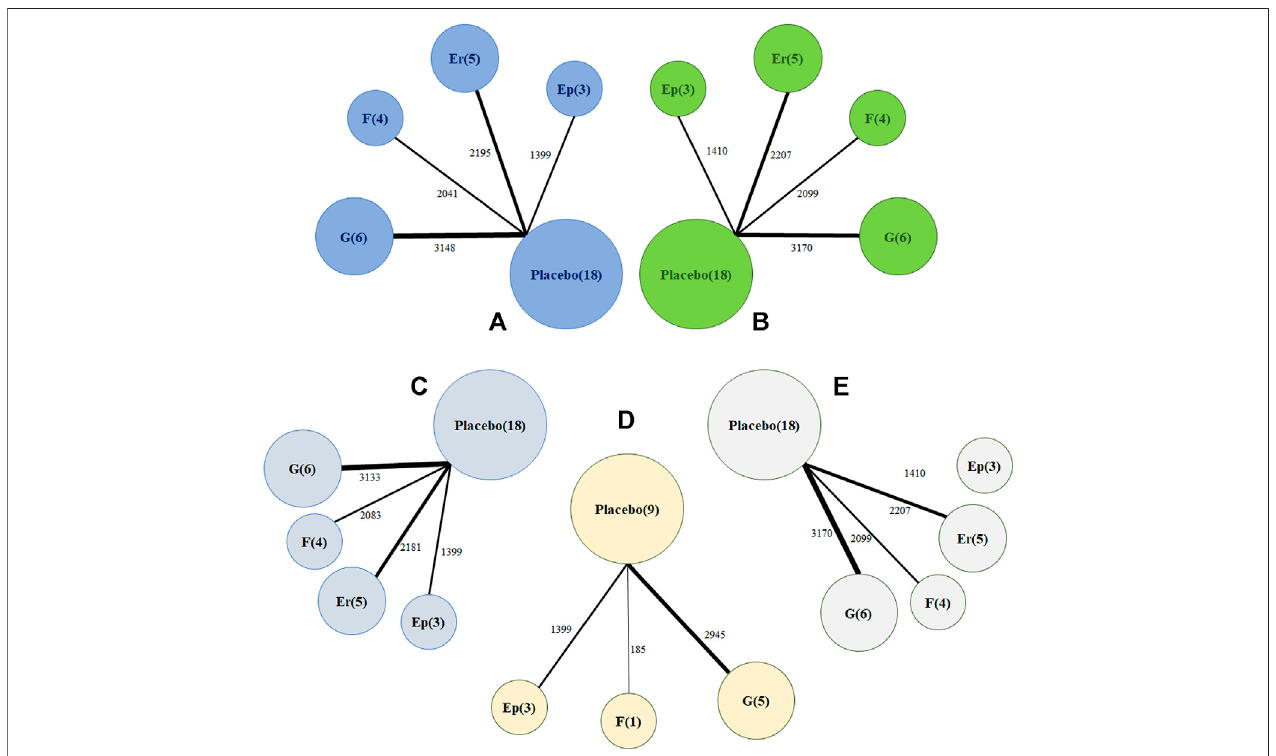
FIGURE 2 | Network plot of (A) change in monthly migraine days (B) treatment-emerging adverse events (C) 50% response rates (D) 75% response rates (E) seriousadverseevents.Thewidthofthelinesisproportionaltothenumberofstudiescomparingeverypairoftreatments,andthesizeofeachcircleisproportionaltothe number of participants. Ep: eptinezumab; Er: erenumab; (F) : fremanezumab; (G) :